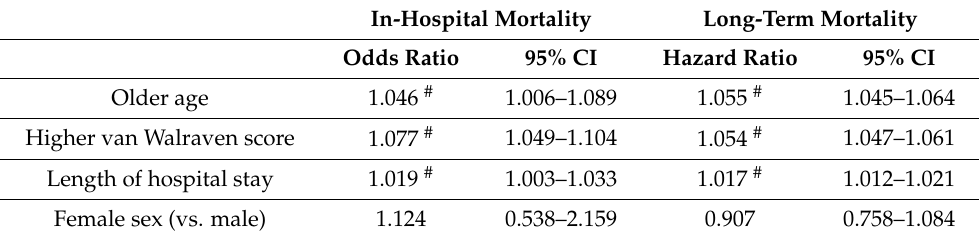
Table 3. Results of the multivariable logistic and Cox regression